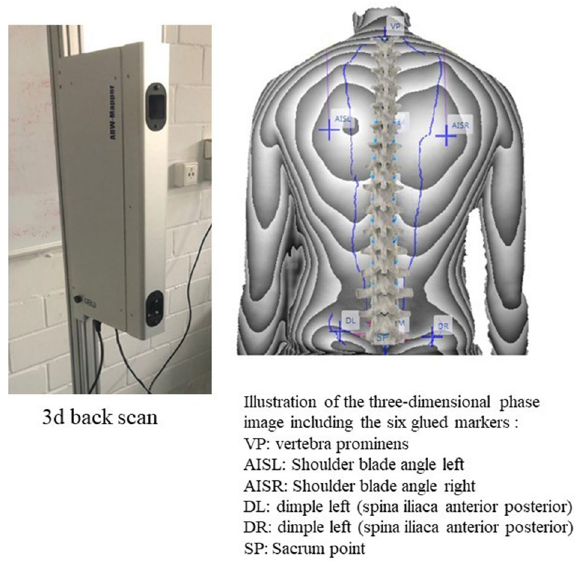
Figure 1. Back scan and the six markers set on the bare back including their